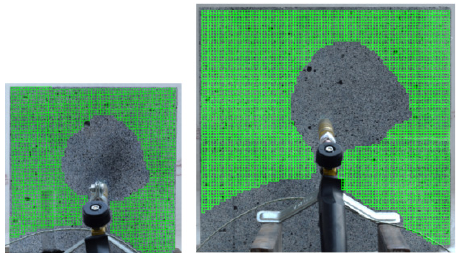
Figure 7. Grid of subsets in medium (200 × 200 mm) and large (300 × 300 mm)